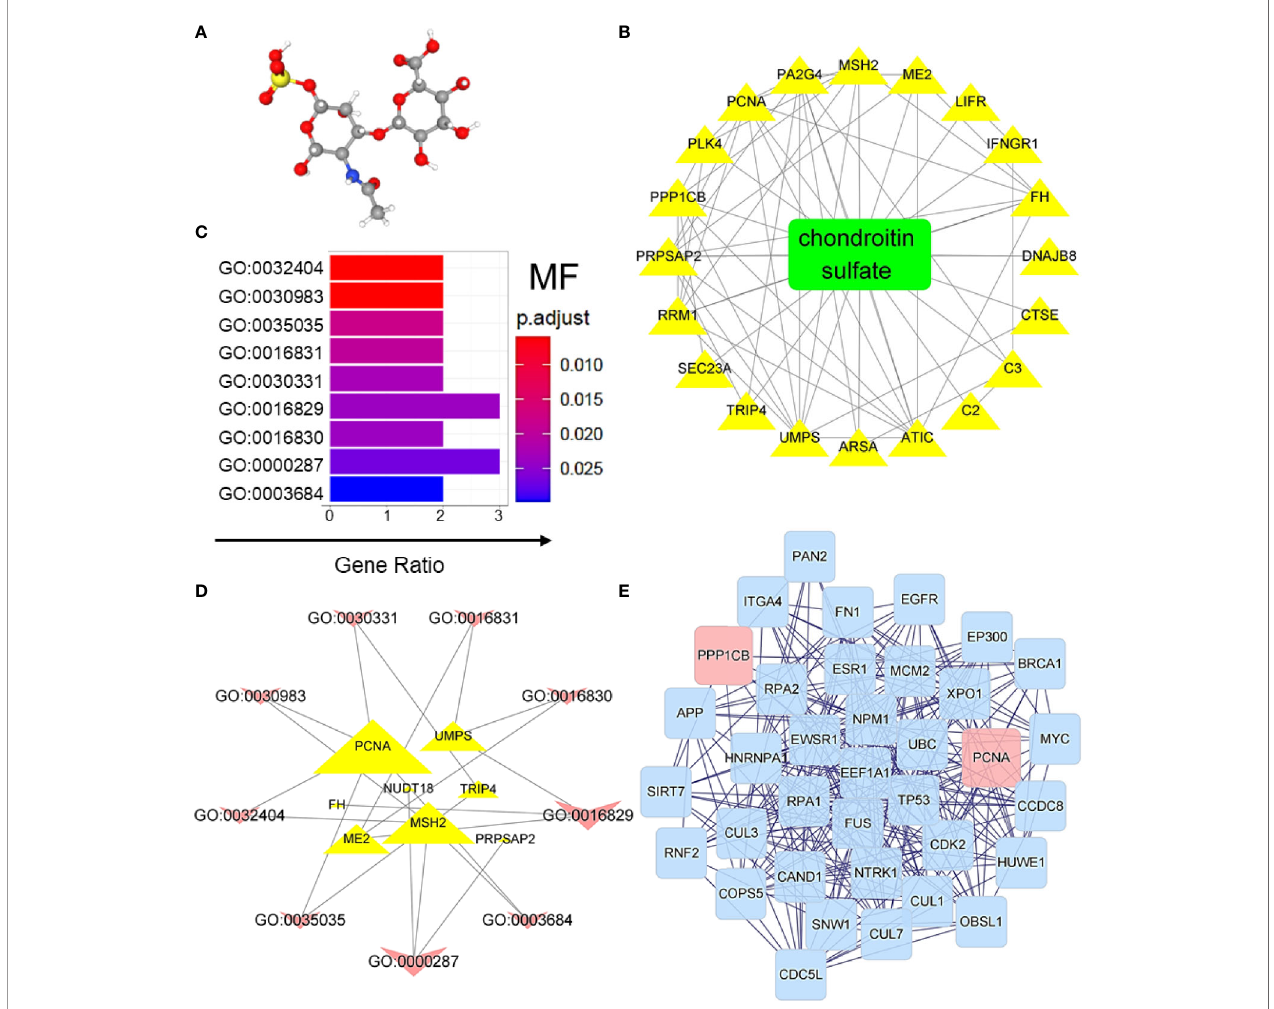
FIGURE 4 | CS was predicted to treat CRC-induced DEGs. (A) 3D structure of CS. (B) Target identi fi cation of CS on CRC-induced DEGs. (C) Regulated GO molecular function prediction of CS on CRC-induced DEGs. GO:0032404, mismatch repair complex binding; GO:0030983, mismatched DNA binding; GO:0035035, histone acetyltransferase binding; GO:0016831, carboxy-lyase activity; GO:0030331, estrogen receptor binding; GO:0016829, lyase activity; GO:0016830, carbon- carbon lyase activity; GO:0000287, magnesium ion binding; and GO:0003684, damaged DNA binding; p.adjust, p -value after correction; and Gene Ratio, the proportion of genes enriched in the molecular function. (D) Interaction of GO molecular function and related target genes of CS. (E) Network topology of CS on CRC-induced DEGs. A total of 1,200 genes were associated with target DEGs of CS. Two kinds of fi ltrating parameters, betweenness centrality (BC) and degree centrality (DC), were calculated. After fi ltering the top 30% BC, the top 10% DC genes were considered as the core